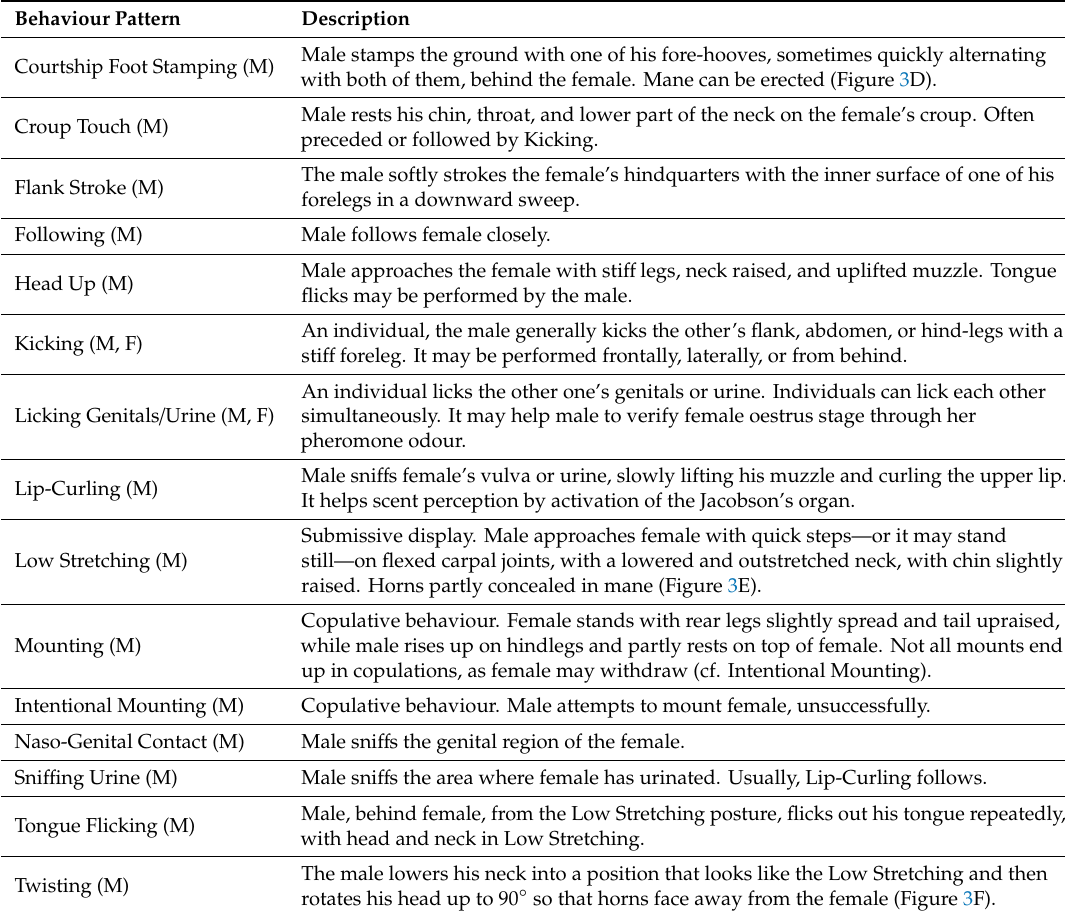
Table 4. Behavioural repertoire of the mainland serow; male and female behaviour patterns in courtship. Behaviour Pattern